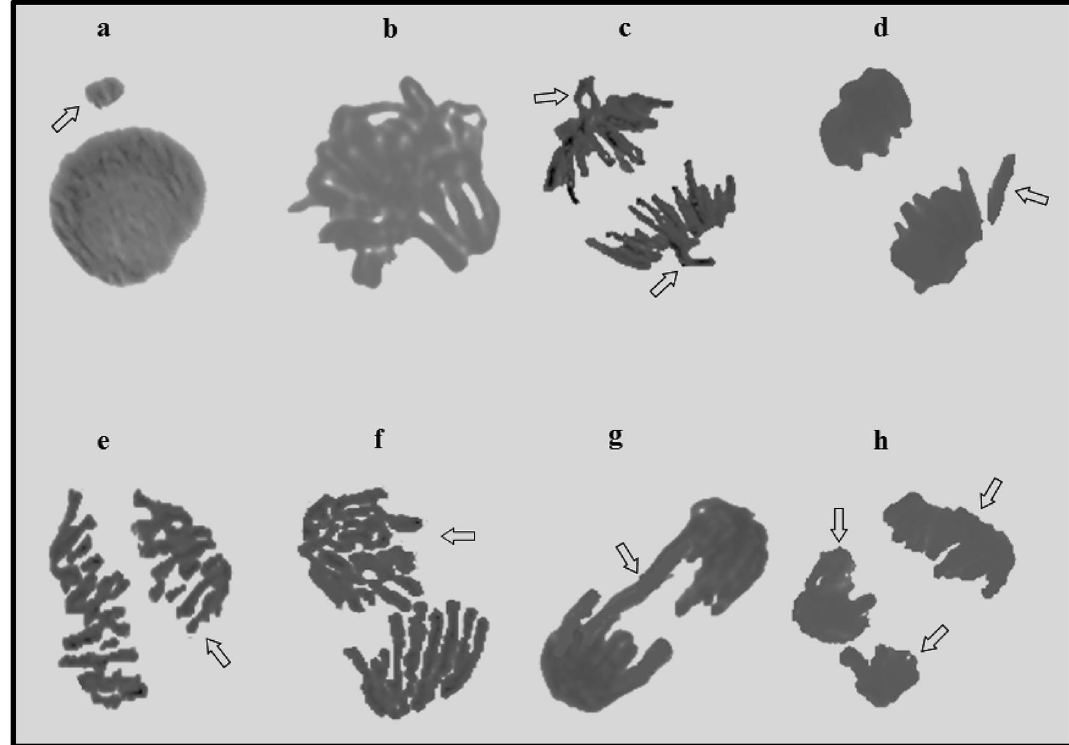
Figure 1. Metaldehyde induced chromosome aberrations. Micronucleus ( a ), sticky chromosome ( b ), vagrant chromosome ( c ), fragment ( d ), unequal distribution of chromatin ( e ), reverse polarization ( f ), bridge ( g ), multipolar anaphase ( h